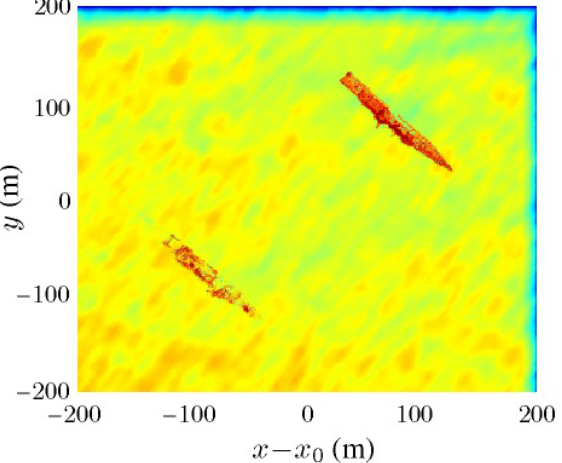
Figure 17. Acquired image of an Arleigh Burke-class destroyer sailing alongside a Ticonderoga-class cruiser, in scale of (40, 90)